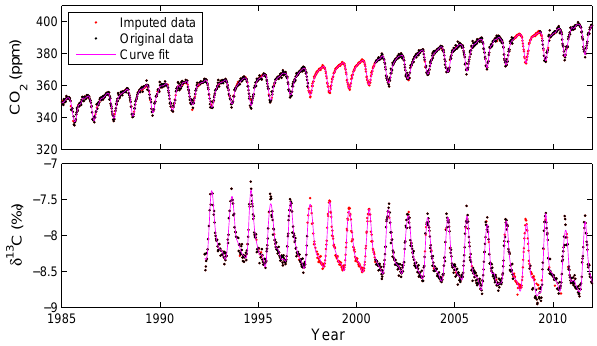
Figure 4. Weekly (top) CO 2 mole fraction (ppm) measurements (black) and (bottom) δ 13 C values (‰) at Cold Bay, Alaska (CBA; 55.2 ◦ N, 162.7 ◦ W), from 1980 to 2012. Imputed values, shown in red, are inferred from a locally averaged seasonal cycle adjusted for anomalies in growth rate. Any remaining missing values are ex- tracted from a fitted piecewise cubic spline curve